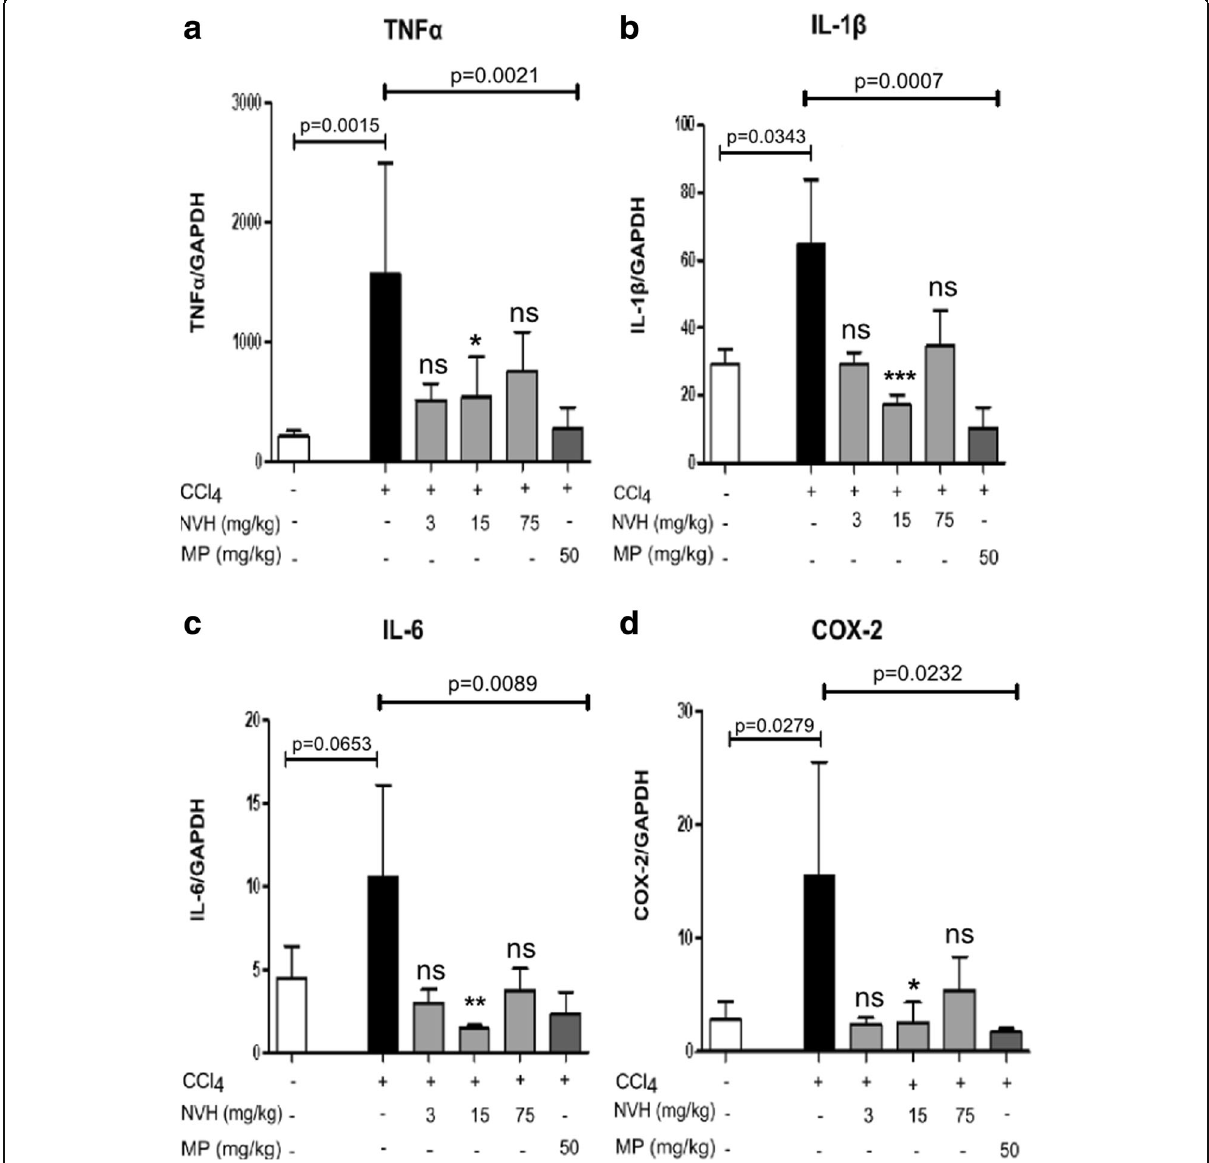
Interleukin-1 beta ( b ), Interleukin-6 ( c ), and Cyclooxygenase-2 ( d ) liver expression in mice. Data are expressed as mean ± Standard Error of the Mean. Significant Dunn ’ s post tests are indicated as *p < 0.05; **p < 0.01; ***p < 0.001; ns: non-significant. The p-value indicates the Mann-Whitney test. One experiment conducted, n = 10 in each mice group. TNF α : Tumor Necrosis Factor alpha; IL1- β : Interleukin-1 beta; IL-6: Interleukin-6;